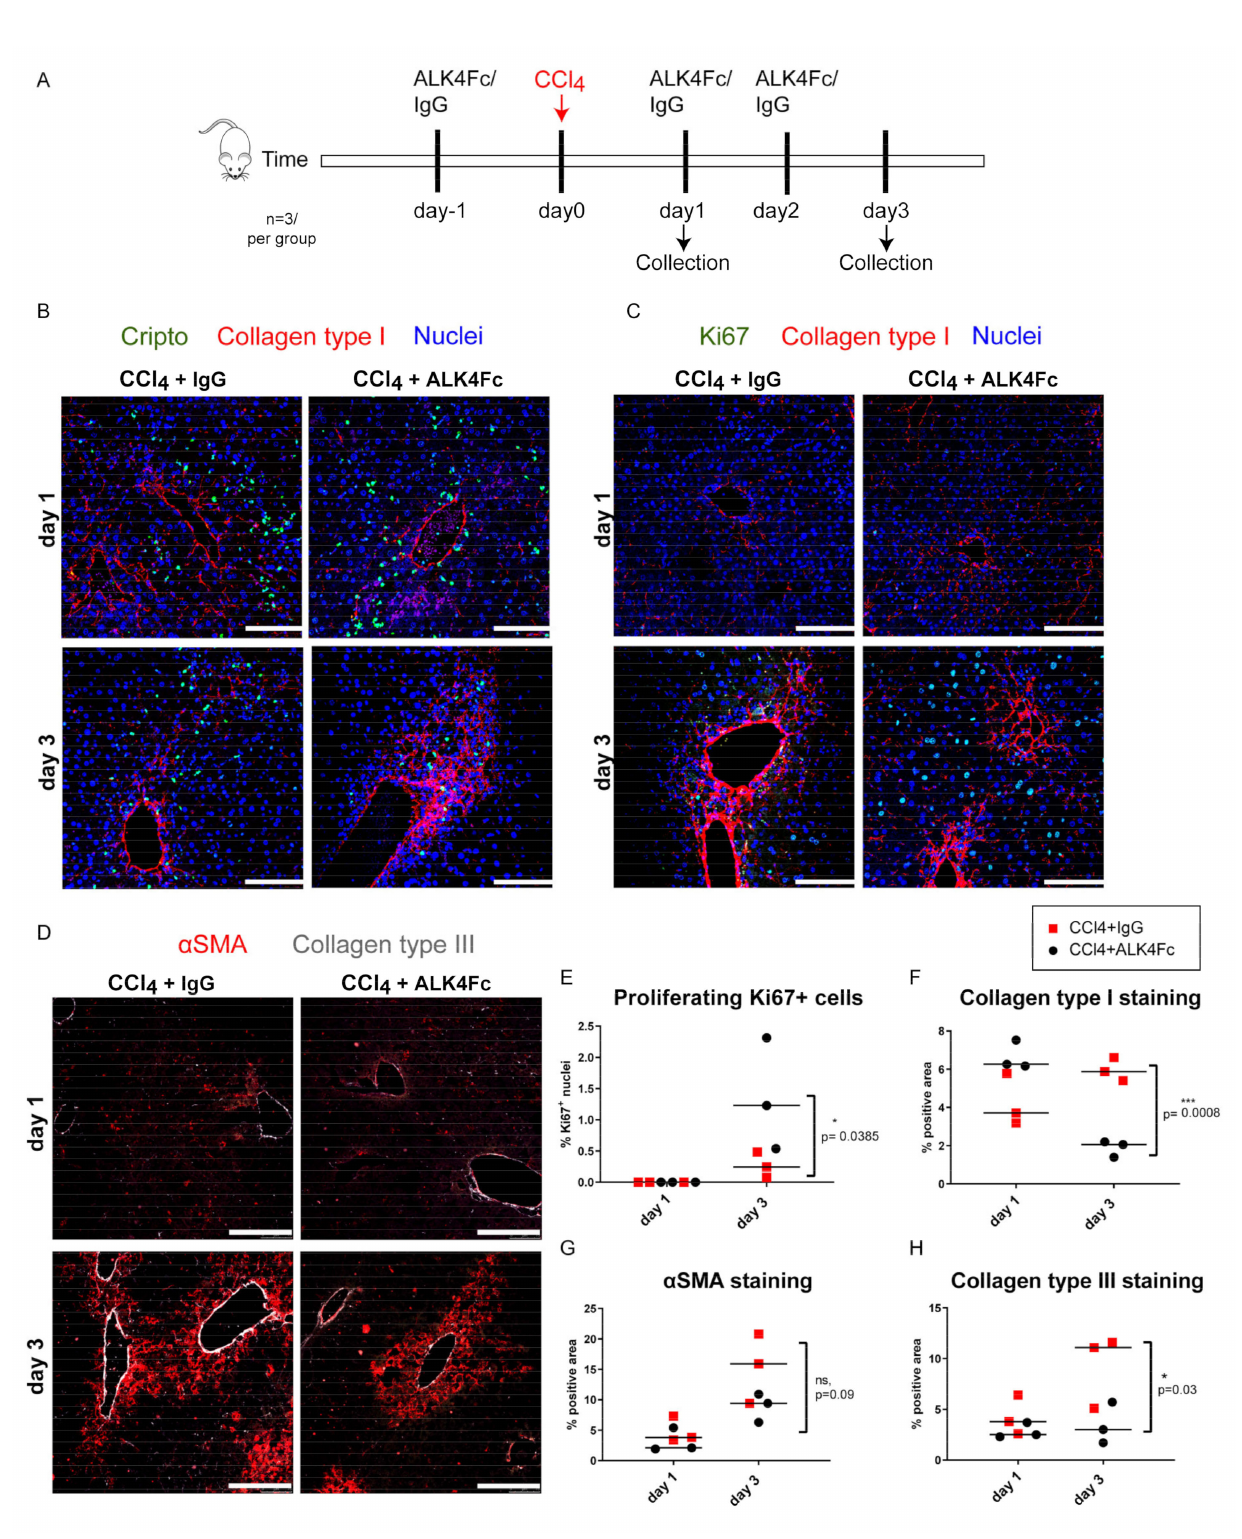
Figure 5. Blocking Cripto function by ALK4Fc leads to reduced collagen deposition in the acute CCl 4 fibrosis model. ( A ) Experimental setup. Mice received ALK4Fc or IgG vehicle (5 mg/kg) 24 h (day 1) prior to one shot of CCl 4 (acute liver fibrosis model, 1 mg/kg, day 0) and once daily for 3 days following CCl 4 . Liver tissues were collected at day 1 and day 3 ( n = 3/ time point and for each of the treatment groups ALK4Fc+CCl 4 and IgG+CCl 4 ). ( B ) Representative images of